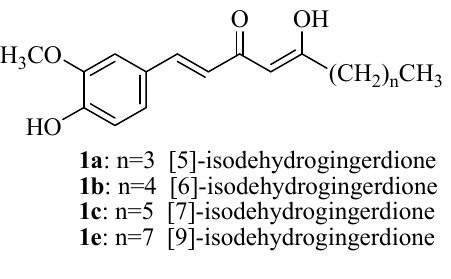
Figure 2. Chemical structures of the synthetic analogues of gingerol and